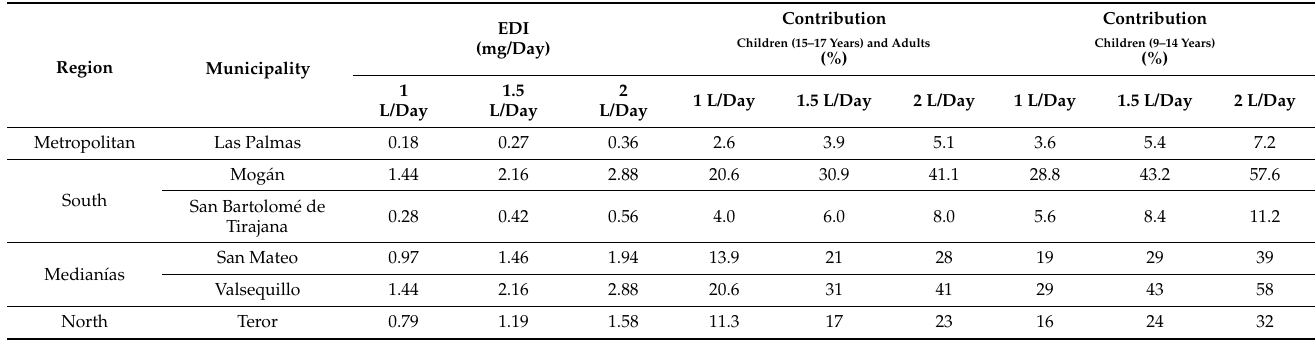
Table 6. Estimated daily intake (EDI) and percentage contribution from consumption of Gran Canaria water supply by children (9–14 and 15–17 years old) and